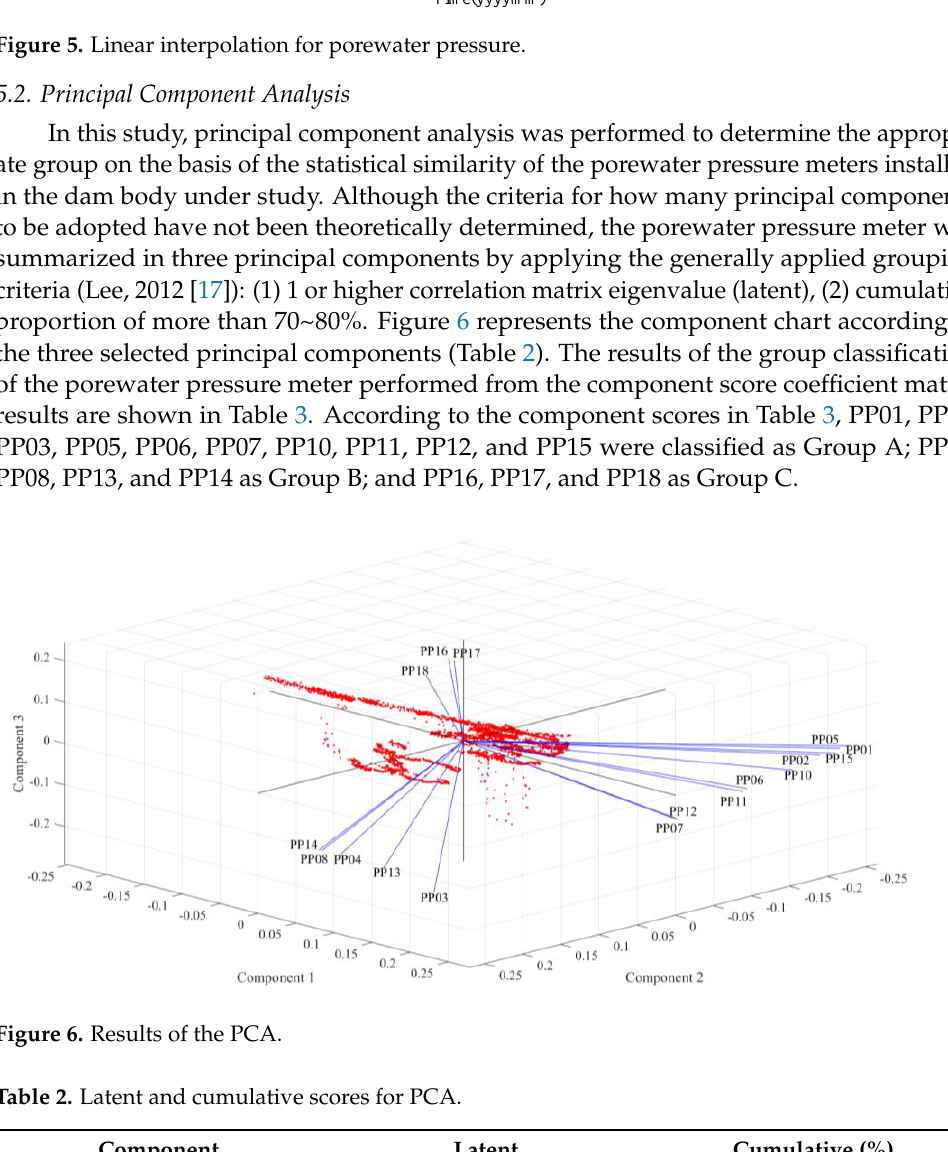
Figure 5. Linear interpolation for porewater pressure. Table 2. Latent and cumulative scores for PCA.